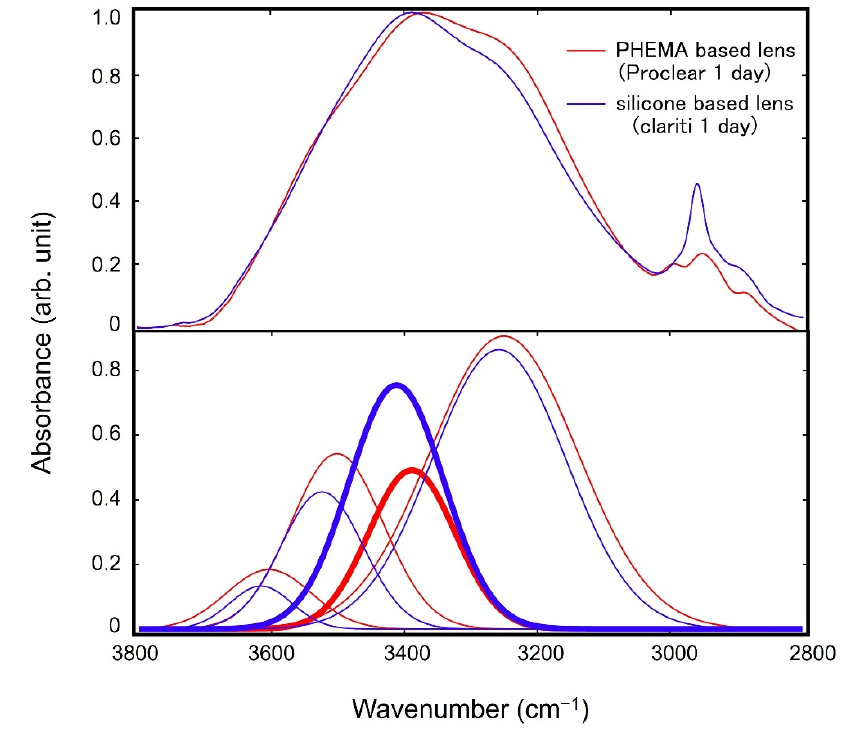
Figure 7. The results of the peak fitting of the spectra of the vicinal water for PHEMA (Proclear 1 day) and silicone-based (clarity ® 1 day) SCLs. The peaks for the CH stretching modes in the region between 3000 and 2900 cm − 1 were removed by assuming peaks for the modes in the fittings.